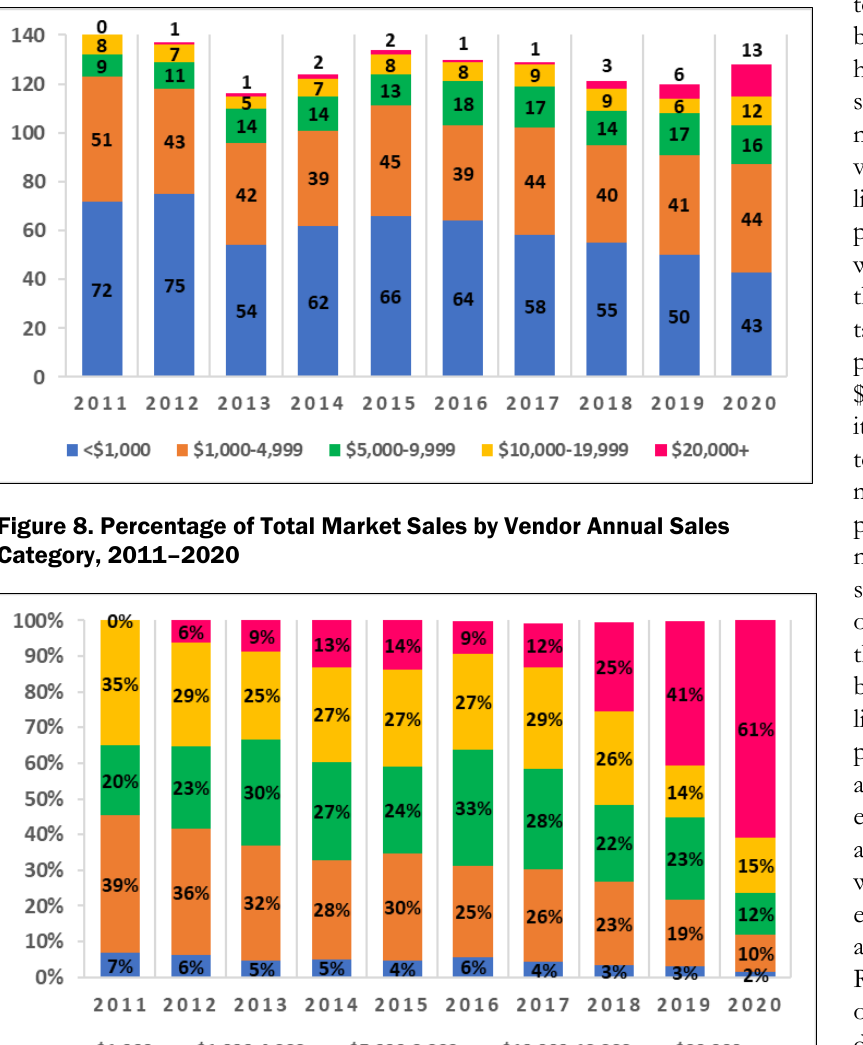
Figure 7. Number of Vendors by Annual Sales Category, 2011 –